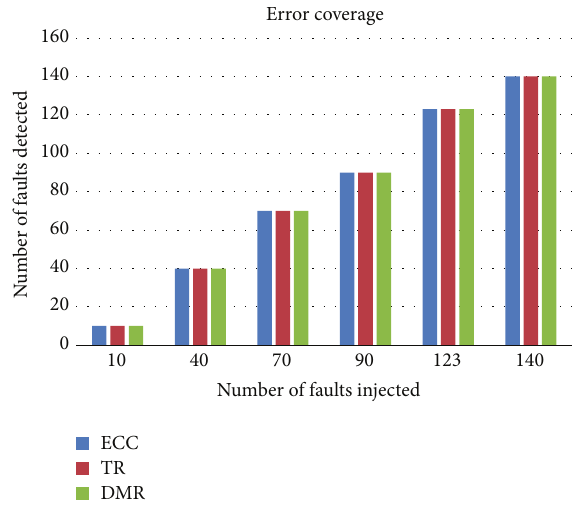
Figure 5: 1-bit injection and